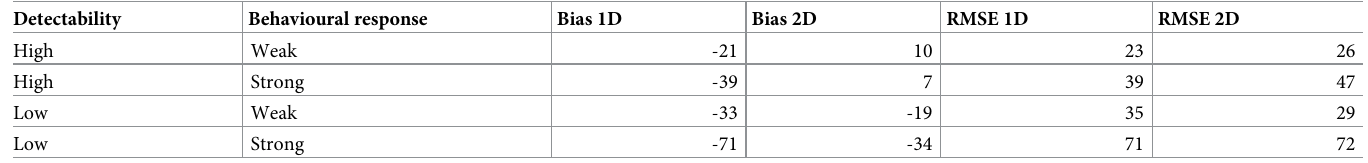
Table 2. Quantifying the bias and Root Mean Squared Error (RMSE) of the abundance estimated using 1D (where only the perpendicular distance to transect is recorded) and 2D (where both the perpendicular and forward distances are recorded) distance sampling, in four scenarios of detectability and intensity of the beha- vioural response to the transect. Low detectability means that the detection probability declines quickly with distance to the transect. Strong behavioural response means that the increase in animal abundance with distance from the transect is slow, meaning that they rarely occur near the transect. Results are given in %. A bias of -50% means that the abundance was under-estimated by 50% on average over 150